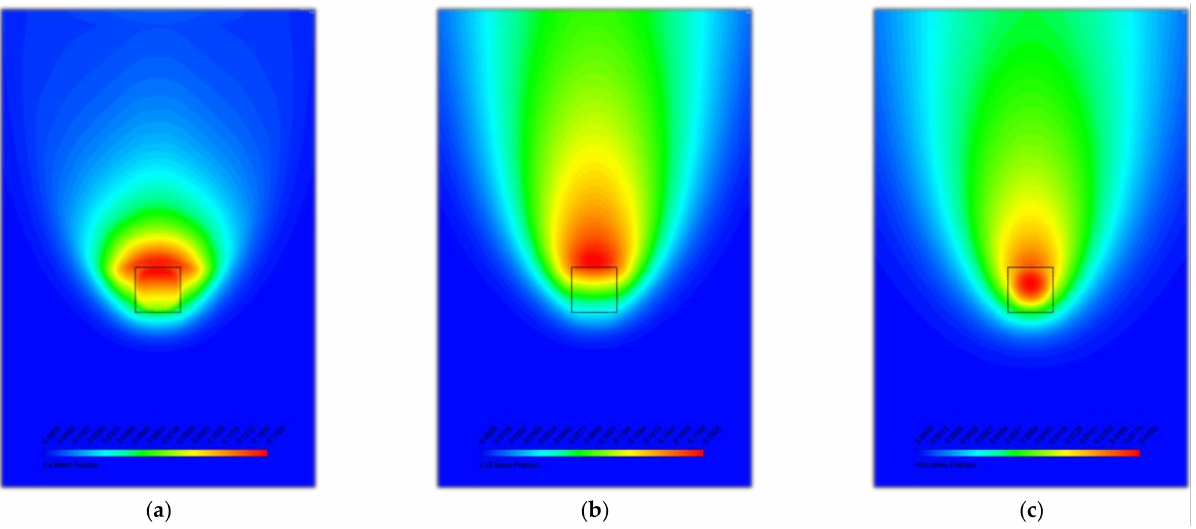
Figure 11. Mass fraction of ( a )CO, ( b )CO 2 , and H 2 O ( c ) at t = 25 s; maximum values: ( a ) 0.1399, ( b ) 0.1926 and ( c ) 0.0192. Figure 12 shows the same gas species in the final phase ( t = 50 s), when most of the biomass has already been converted and the transition is made to the char combustion phase. The maximum concentrations of the species are: CO = 4.84%, CO 2 = 5.45%, and H 2 O = 0.3%, three to four times lower compared to the previous